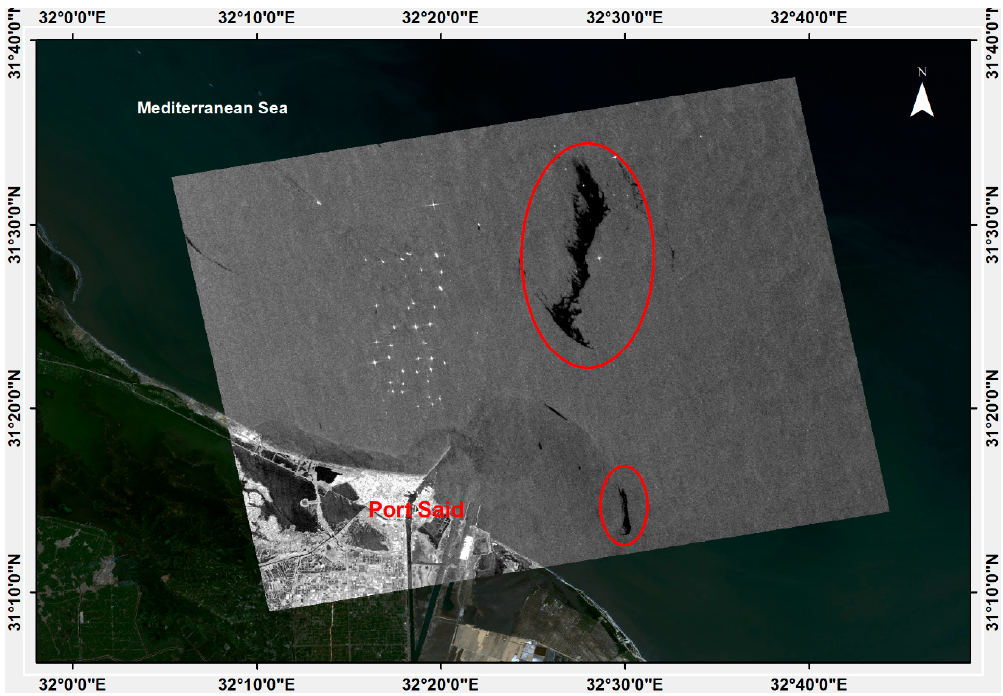
Figure 4. The largest oil spill event detected near the entrance of the Suez Canal.